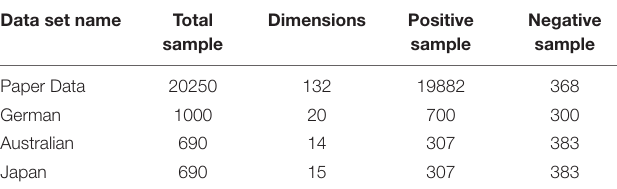
TABLE 1 | Dataset and its parameters.